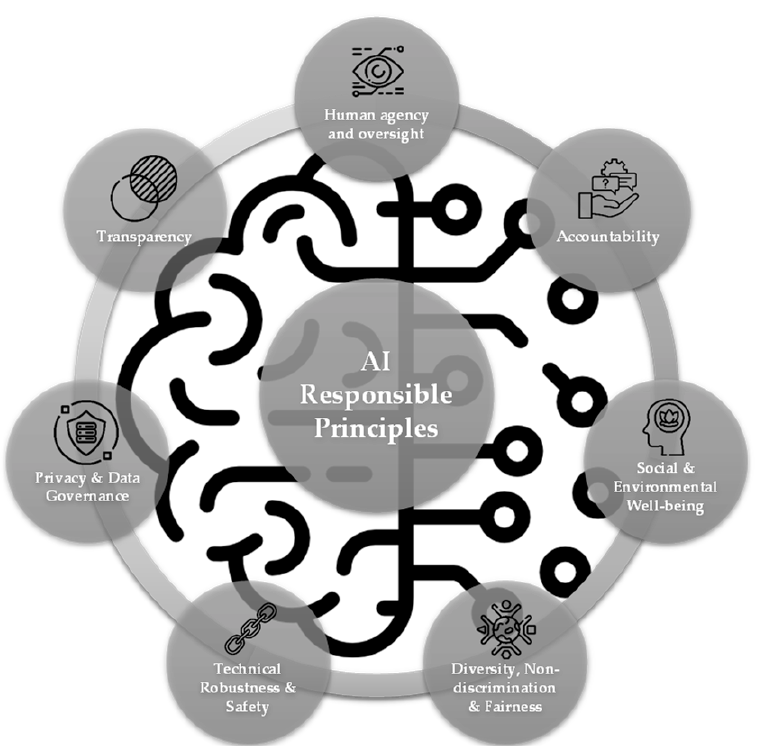
Figure 4. AI responsible principles based on European Commission. Source: Own elaboration.